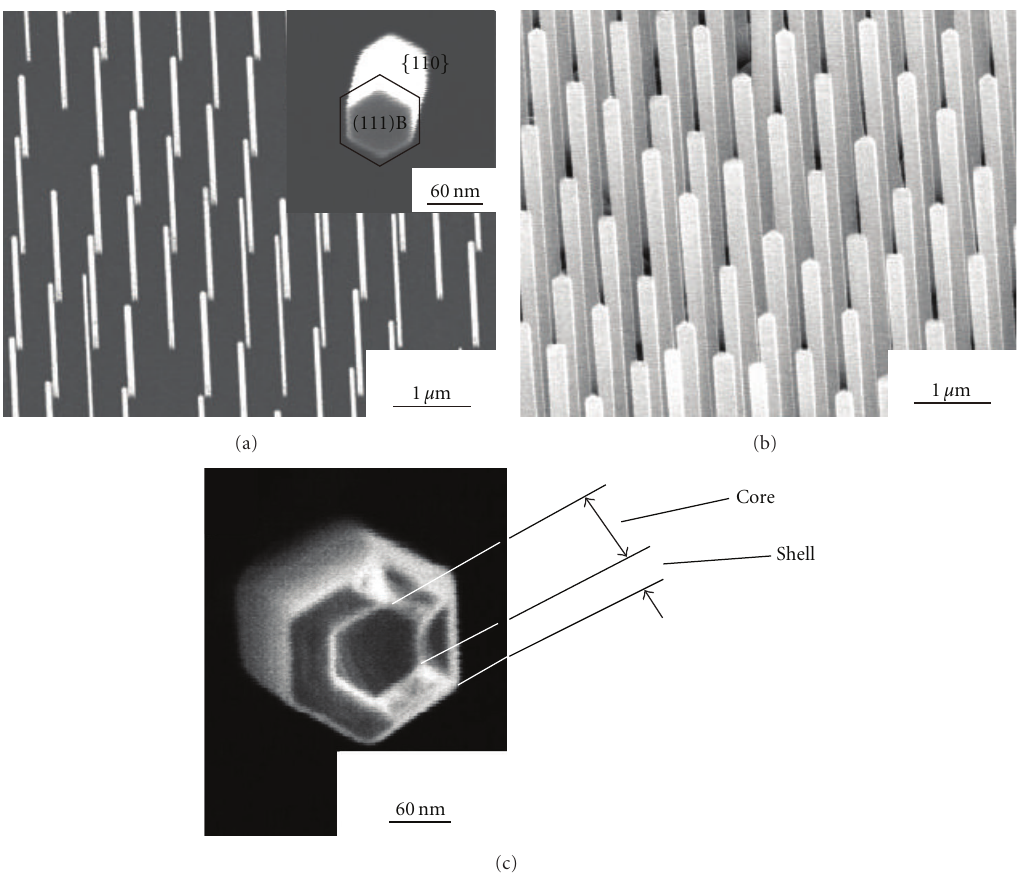
Figure 17: SEM images of grown nanowires. (a) SEM images of GaAs nanowires. Inset has image of nanowire from top. (b) SEM image of nanowires after growth of AlGaAs. (c) Top-view SEM image of GaAs/AlGaAs core-shell nanowire after preferential etching